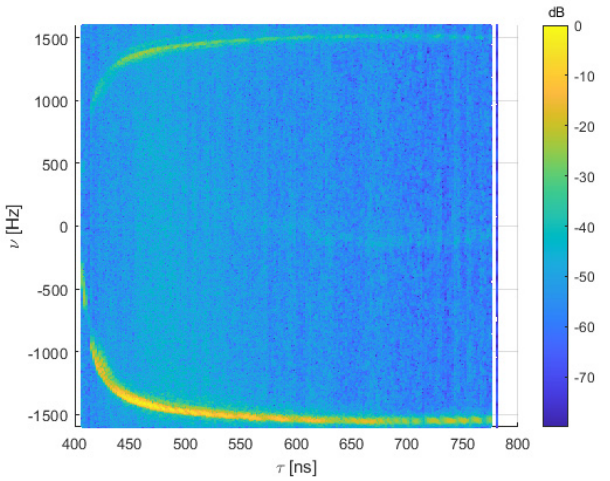
Figure 22. Delay spread in the highway: ( a ) variation along the measurement process; ( b ) CDF of the spread.